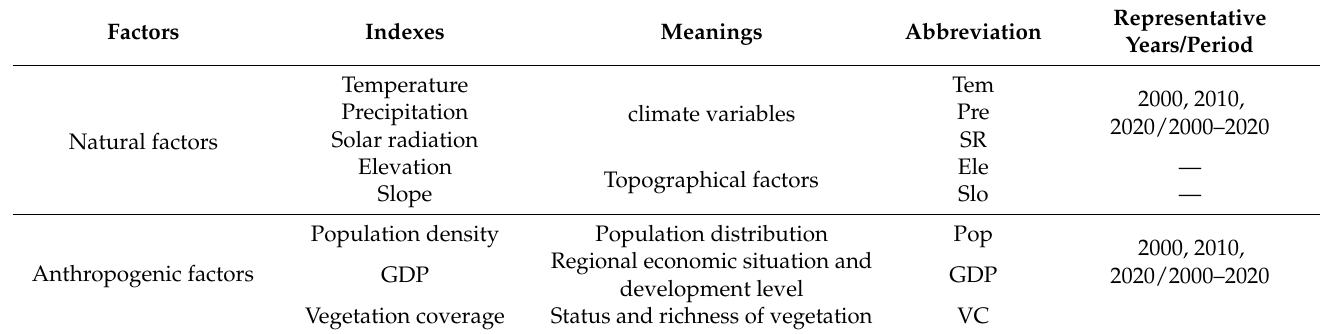
Table 1. Description of driving factors of NPP spatial pattern and change